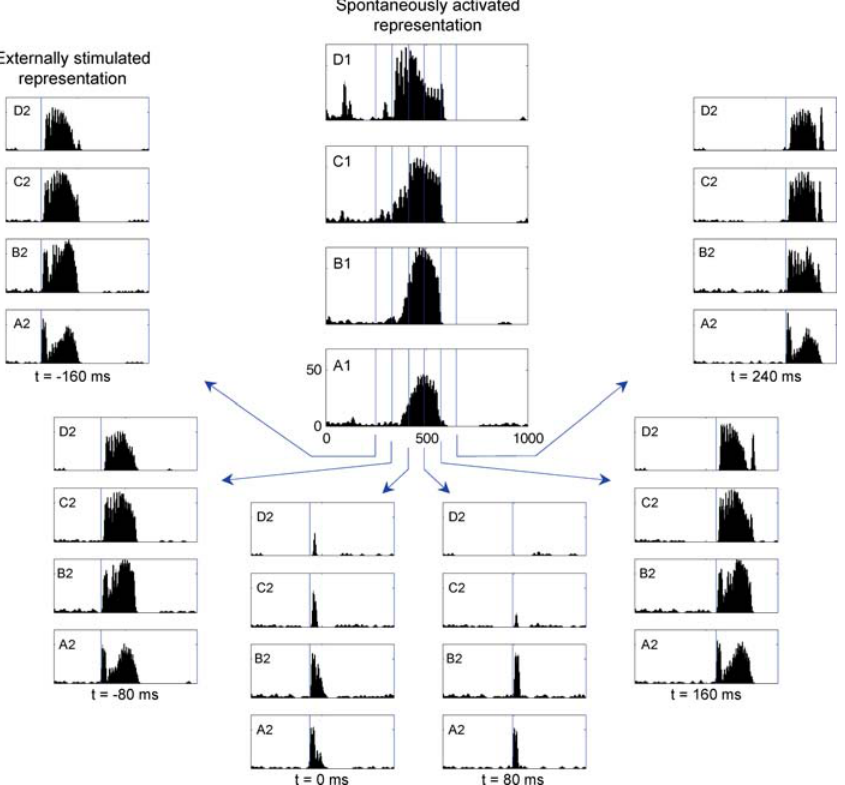
Figure 8. Competition between Spontaneous Workspace Activity and External Stimulation: A Possible Correlate of Inattentional Blindness In this simulation, a time period was selected during which the representation of stimulus T1 became spontaneously activated in the absence of any external stimulation (note how the activation starts at the higher areas C and D, and propagates top-down to areas B1, then A1). Starting from the same initial state, the simulation was then digitally reproduced with the addition of an external stimulation of stimulus T2 at various times relative to the peak of spontaneous activity in area D. When T2 occurred before or after the period of spontaneous T1 activity, a normal global reverberant activation of T1 ensued. However, when T2 occurred during spontaneous T1 activity, T2 processing was limited to a short, bottom-up wave through areas A2, B2, and, to a lesser and more variable extent, areas C and D. Such blocking of T2-induced activity, similar to the attentional blink [22], may represent the cerebral basis of a state of ‘‘ inattentional blindness, ’’ in which external stimuli fail to be detected during periods of spontaneous thought. DOI: